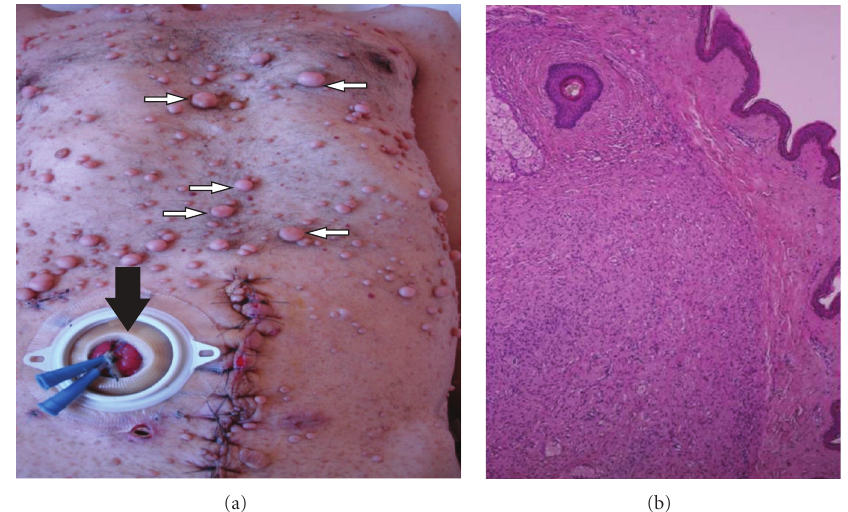
Figure 3: (a) Numerous cutaneous neurofibromas (small white arrows) and the performance of the ileal stoma (black arrow) located below the right line between umbilicus and the anterior superior iliac spine. (b) Microscopic view of resected cutaneous neurofibroma at the site of the performed stoma (H-E stain X 2.5).